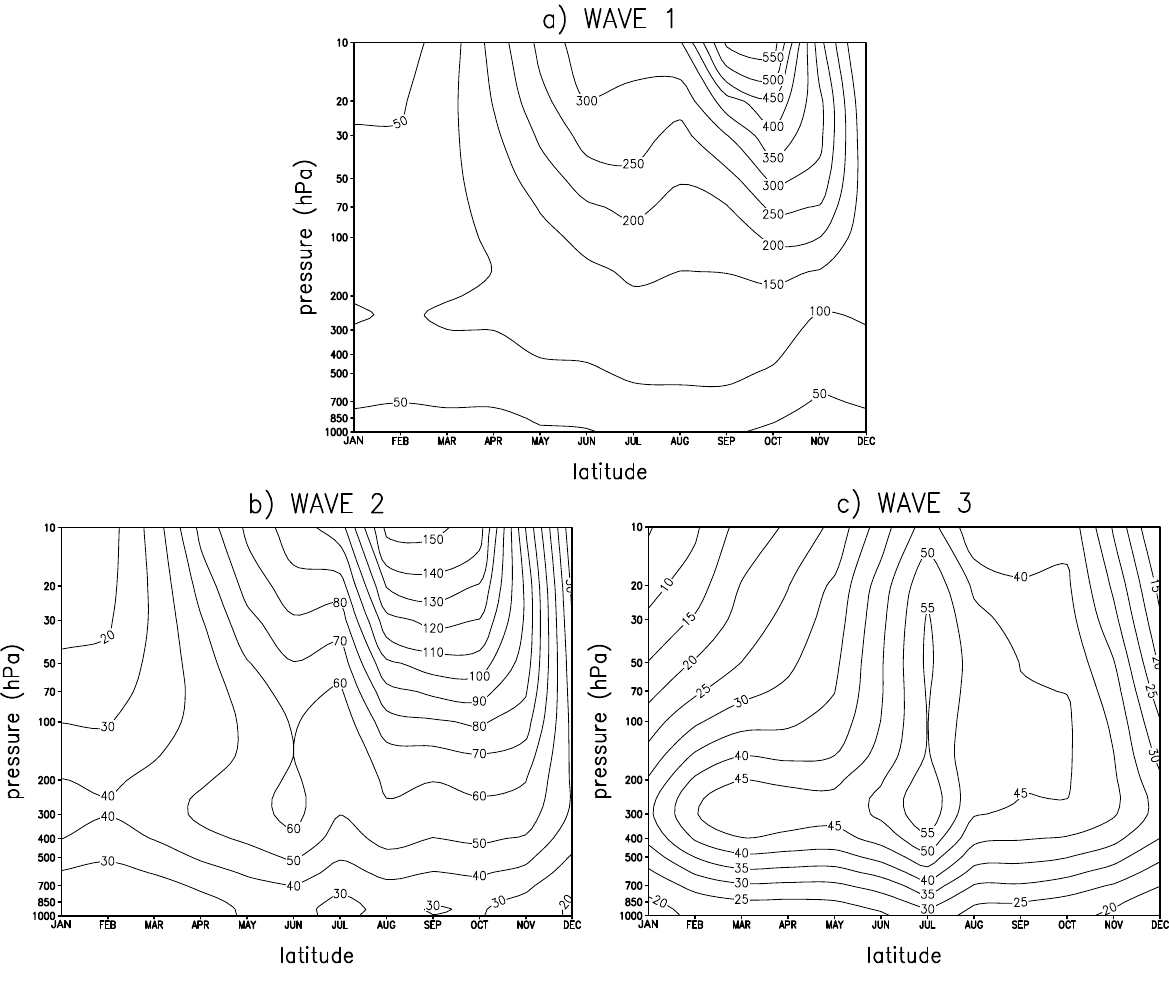
Fig. 3. Monthly variation of the amplitudes (m) of QS waves 1 (a) , 2 (b) and 3 (c) at 60 ◦ S. Contour interval is : (a) 50m, (b) 10m, and (c)